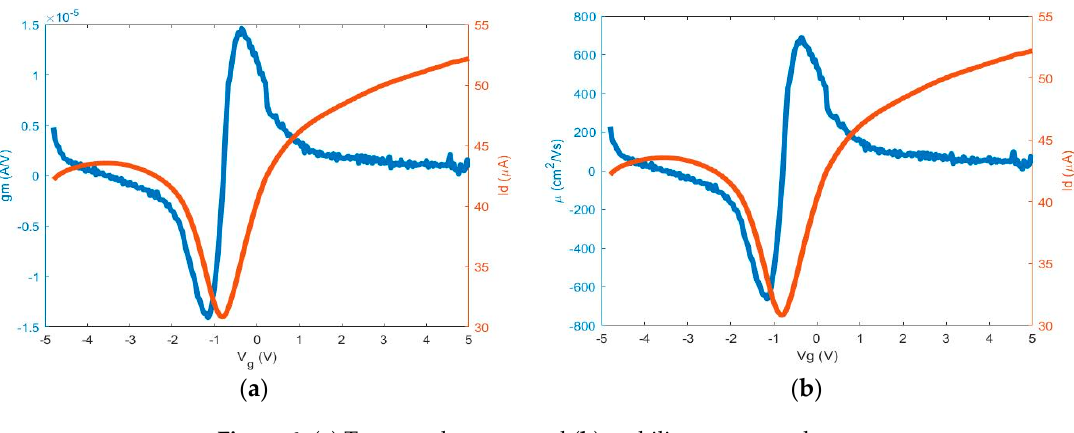
Figure 6. ( a ) Transconductance and ( b ) mobility vs. gate